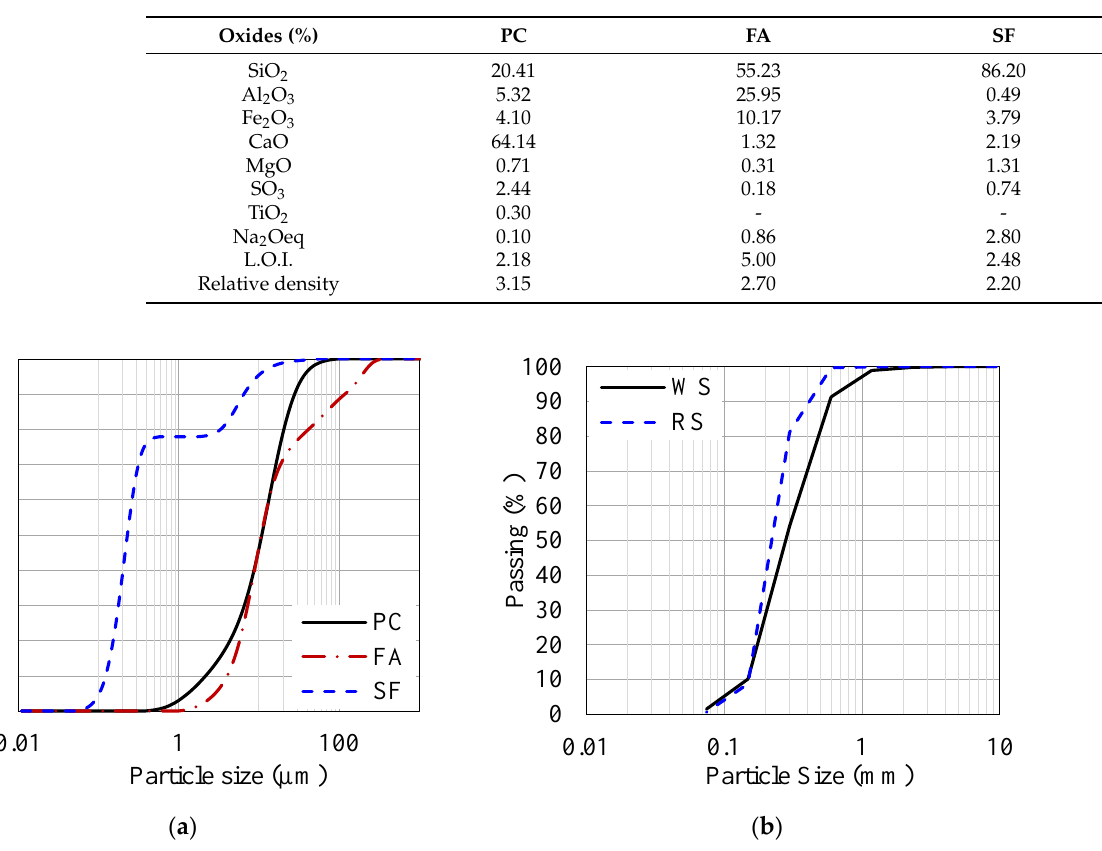
Table 1. Physicochemical properties of PC and SCMs.